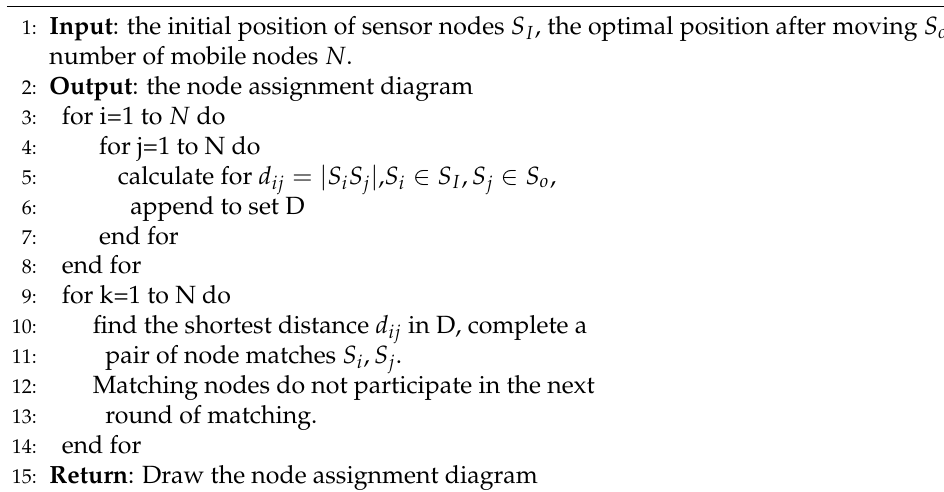
Algorithm 2 Greedy node-matching